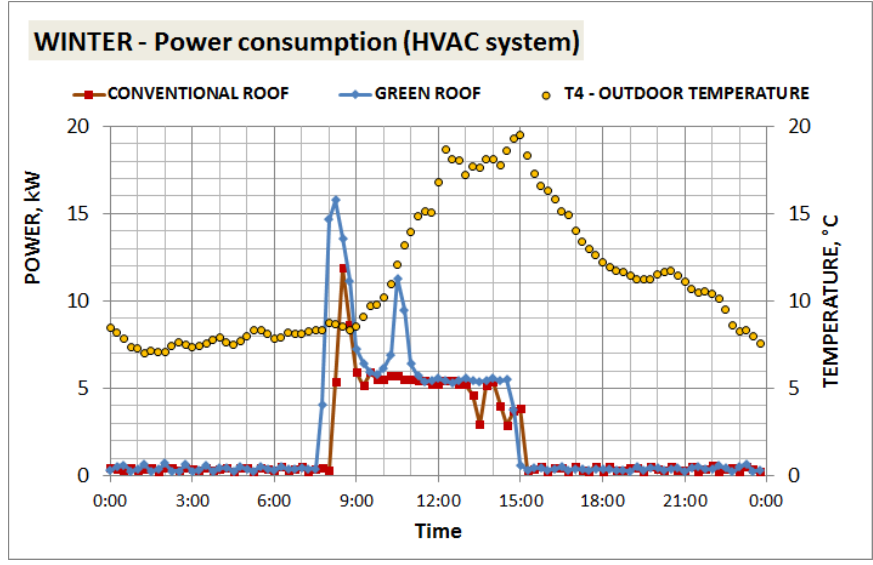
Figure 12. Comparison of similar days with and without a green roof in the winter period.